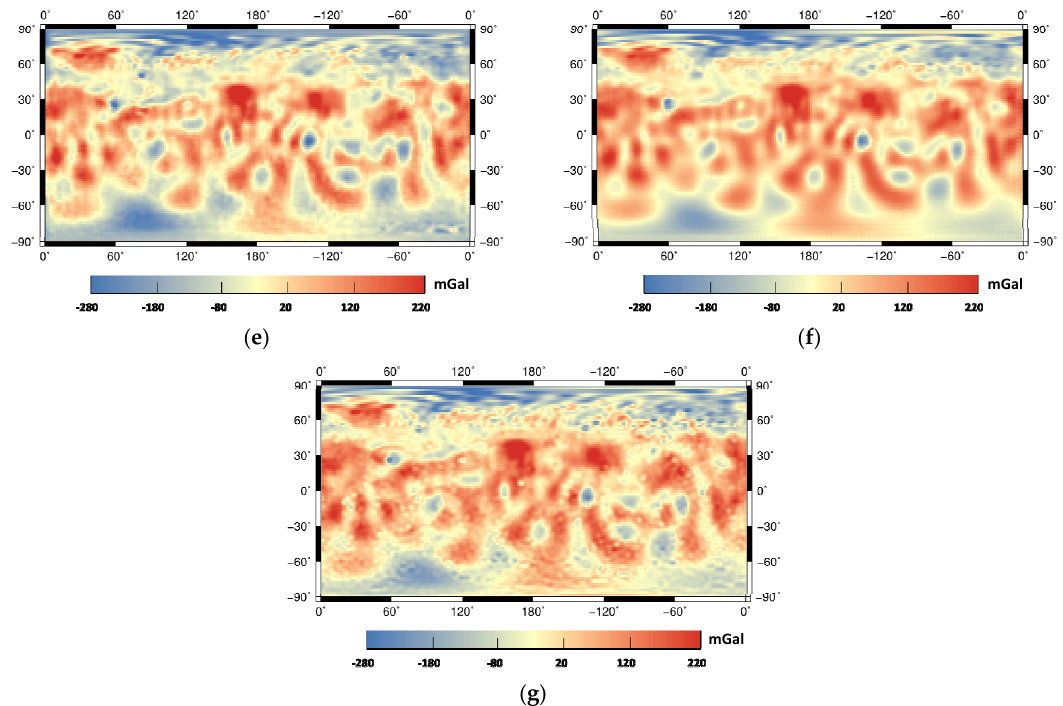
Figure 7. Visual comparison of 100-degree reconstructed spatial structure at ×2 scale of Mercury’s gravity data. ( a ) HgM007 100 degree; ( b ) HgM008 100 degree; ( c ) Bicubic 100 degree; ( d ) Coarse output 100 degree; ( e ) Fine output 100 degree; ( f ) Coarse output 100 degree after fine-tuning; ( g ) Fine output 100 degree after fine-tuning.